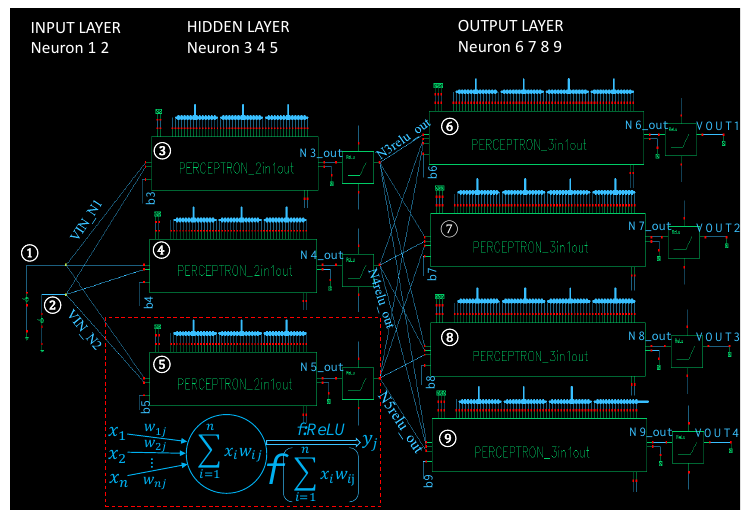
Figure 7. Top-level schematic of our MLP